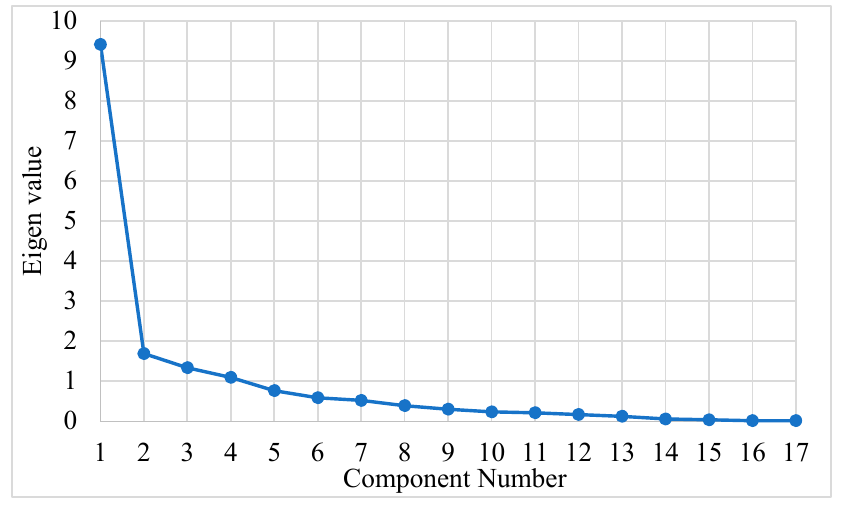
Figure 3. Screen plot. Table 2. Factor loadings of green walls implementation barriers.